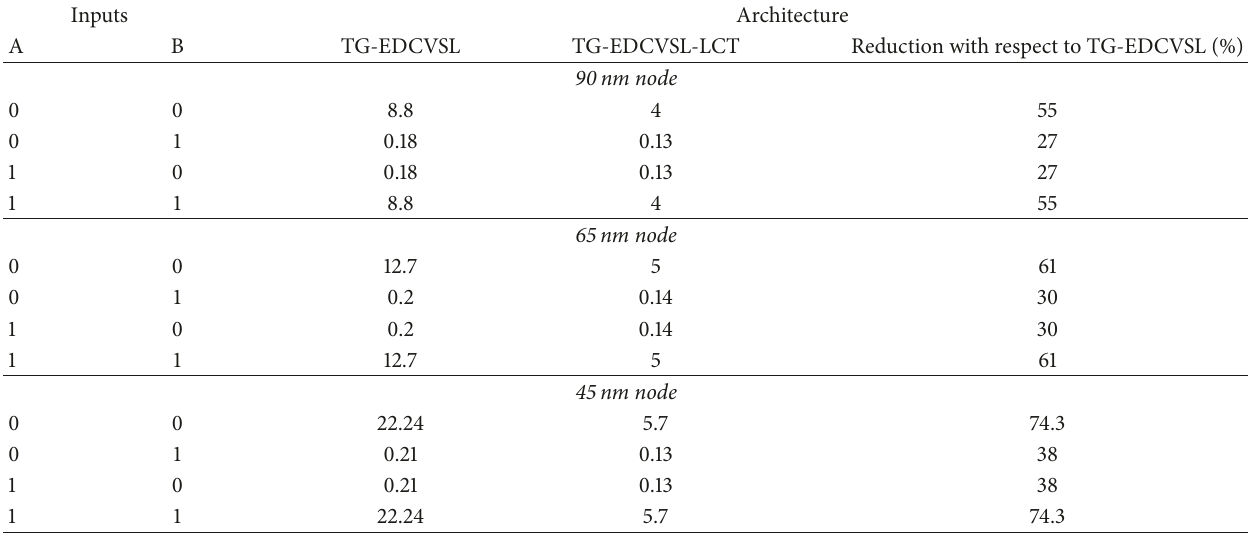
Table 3: Leakage power (nW) for TG-EDCVSL and TG-EDCVSL-LCT based XOR-XNOR2 gate topologies.